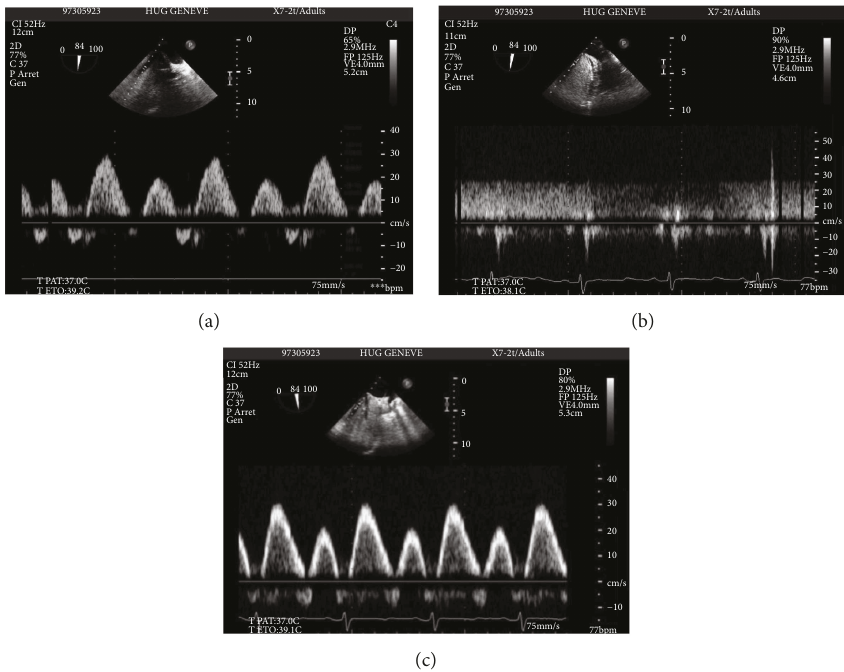
Figure 1: Hepatic blood fl ow at the middle hepatic vein measured by transesophageal echocardiography. (a) Normal triphasic Doppler signal of HBF from the MHV at time 2 (end of CRS, before abdominal fi lling). (b) Nonpulsatile Doppler signal at time 3 (end of HIPEC, before abdominal emptying). (c) After emptying abdominal cavity, at time 4 (end of procedure, after abdominal emptying and removal of abdominal drainage), HBF returns to normal Doppler signal waveform. HBF: hepatic blood fl ow; MHV: middle hepatic